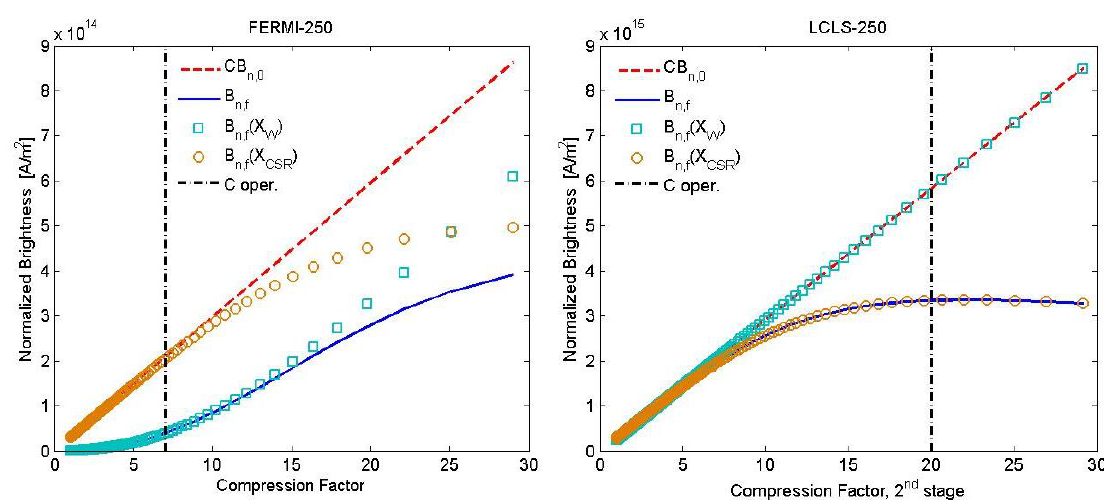
Figure 9. Electron beam z-projected five-dimensional (5-D) brightness, as function of the bunch length compression factor, for a 250 pC beam in the FERMI (left plot) and the LCLS S-band linac (data from [67]). The nominal (unperturbed) brightness is in dashed line, the effective (perturbed) brightness is in solid line, coherent synchrotron radiation (CSR, circles) and geometric transverse wakefield (GTW, squares) dominated brightness is also